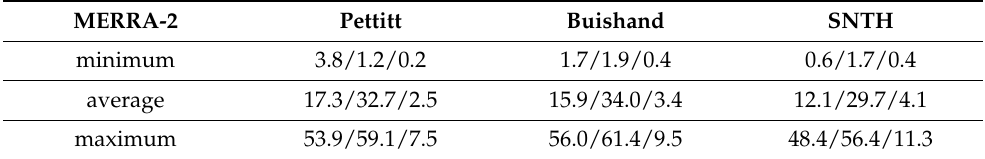
Table 3. Minimal, average and maximal share of discontinuities to all discontinuities in percentage in 2003/2004/2005 from MERRA-2 for the Pettitt test, the Buishand test and the Standard Normal Homogeneity